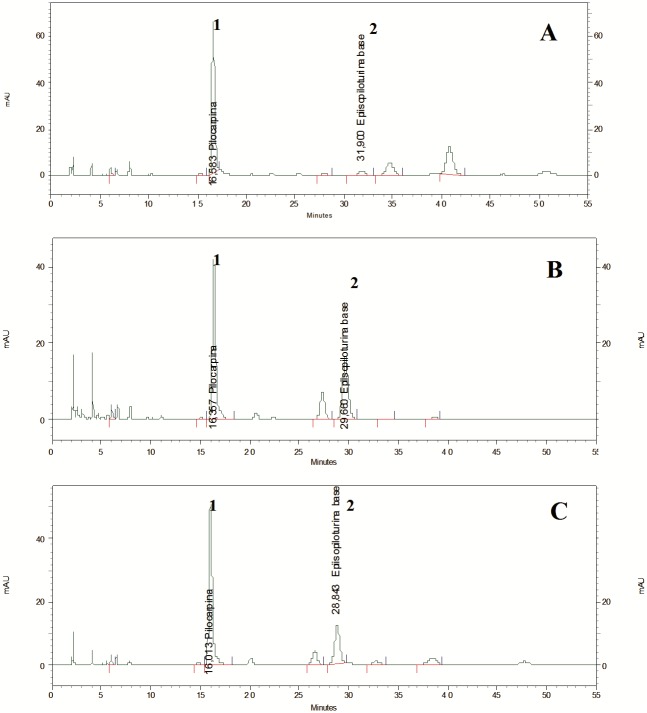
Typical chromatographic profiles obtained by HPLC analysis of the three cultivated populations of P. microphyllus.S01 group (jaborandi green line). (B) S02 group (jaborandi traditional line). (C) S03 (jaborandi traditional line). Peak no. 1: pilocarpine; peak no. 2: epiisopiloturine.